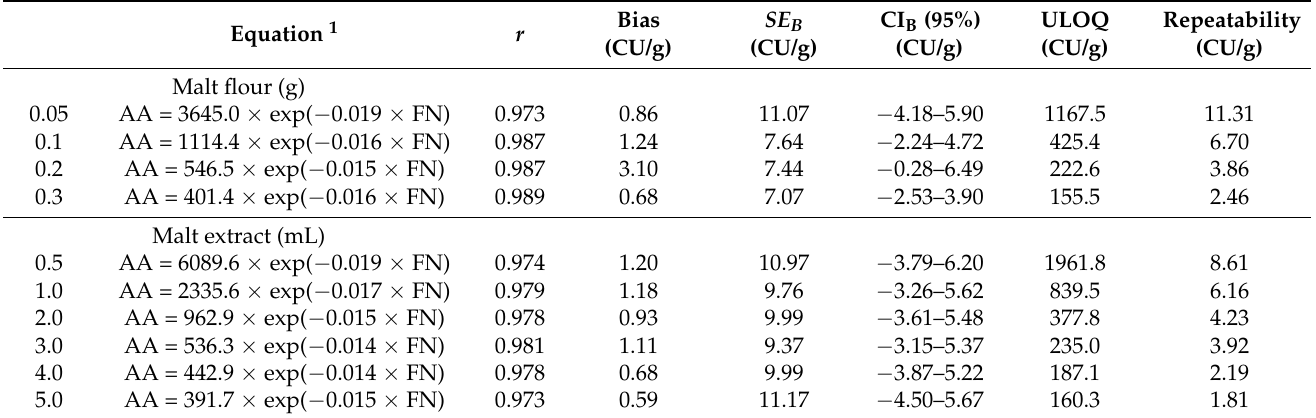
Table 4. Agreement between standard Ceralpha method and modified Falling Number method (nonlinear relationship between Falling Number and α -amylase